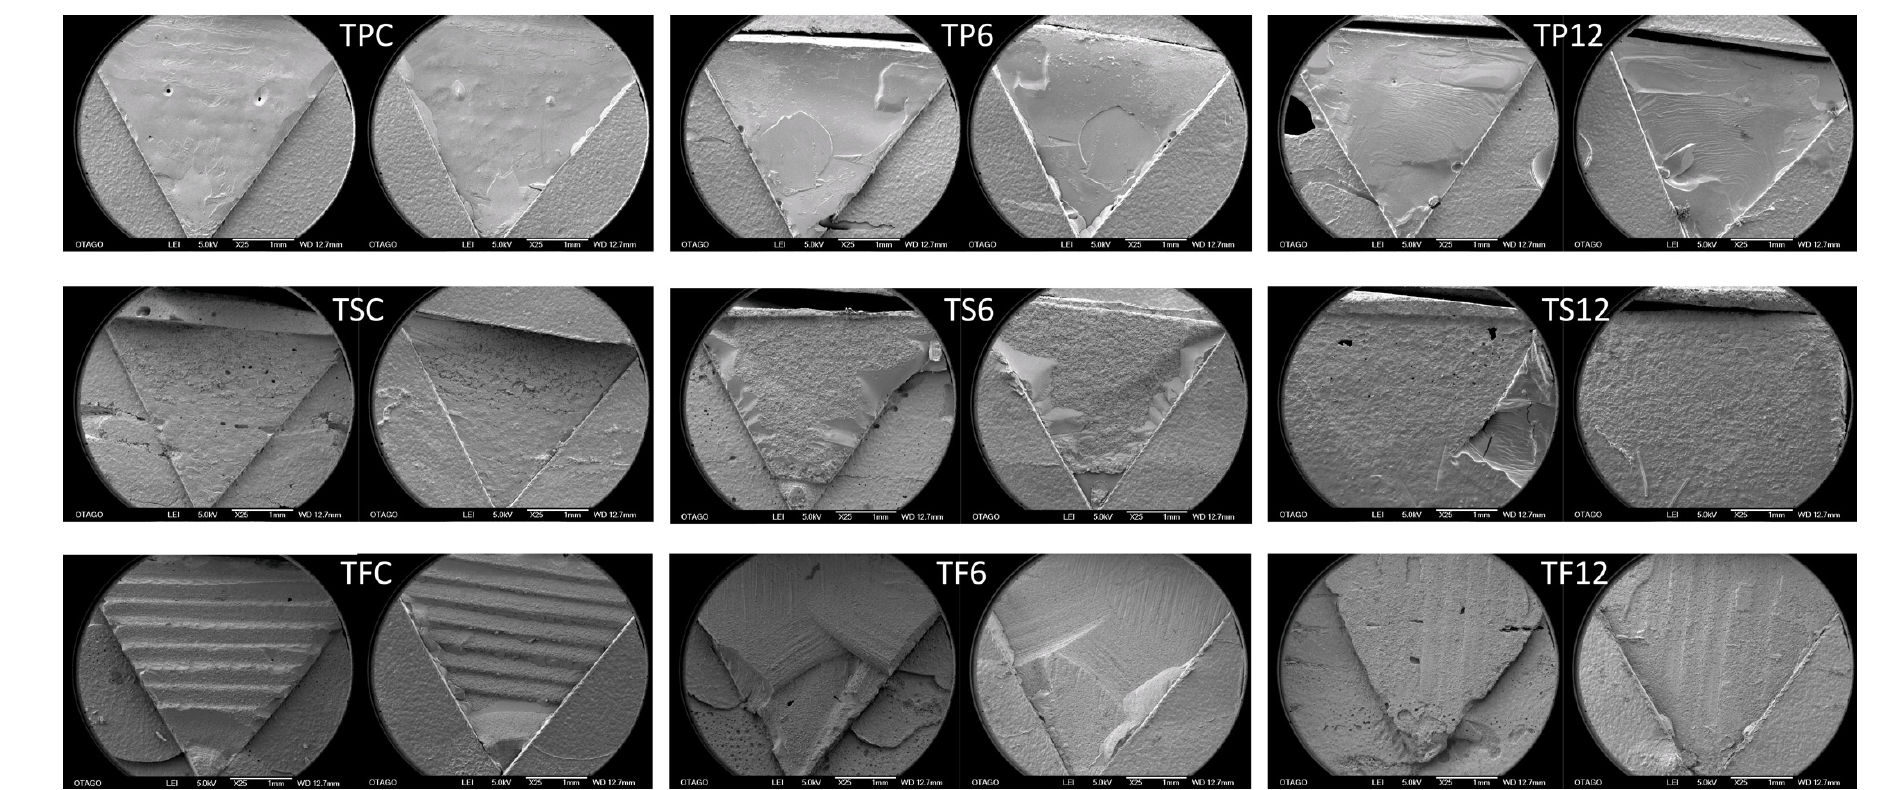
Figure 6. Representative SEM images (×25 magnification) of one specimen per group ( T : Telio CAD, P : Pala-Creative, S : SR Nexo, F : Ceramage, C : control, 6: 6 months, 12: 12 months). On the left-hand side of each slide, the composite is shown, on the right-hand side of each slide, CAD material is shown.